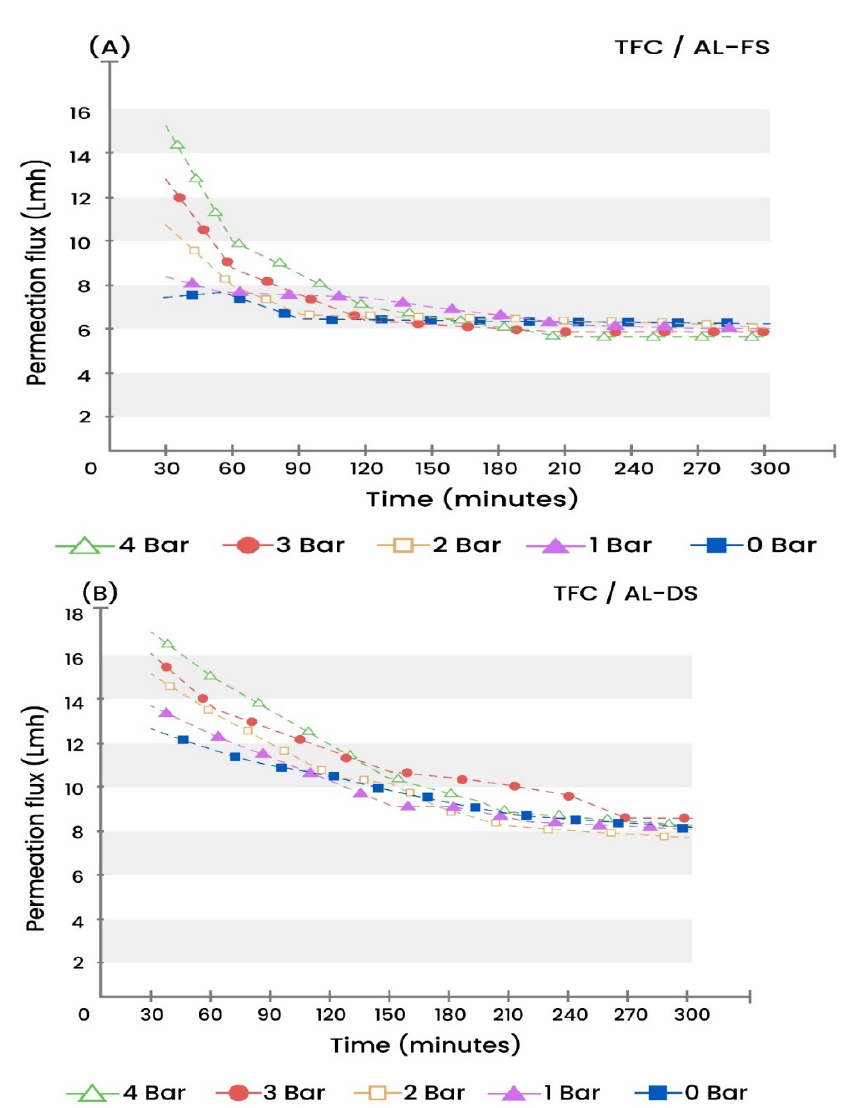
Figure 4. Permeation flux of the FO process over the operating time at applied hydraulic pressures between 0 and 4 bar using TFC membrane in ( A ) AL-FS and ( B ) AL-DS orientations.